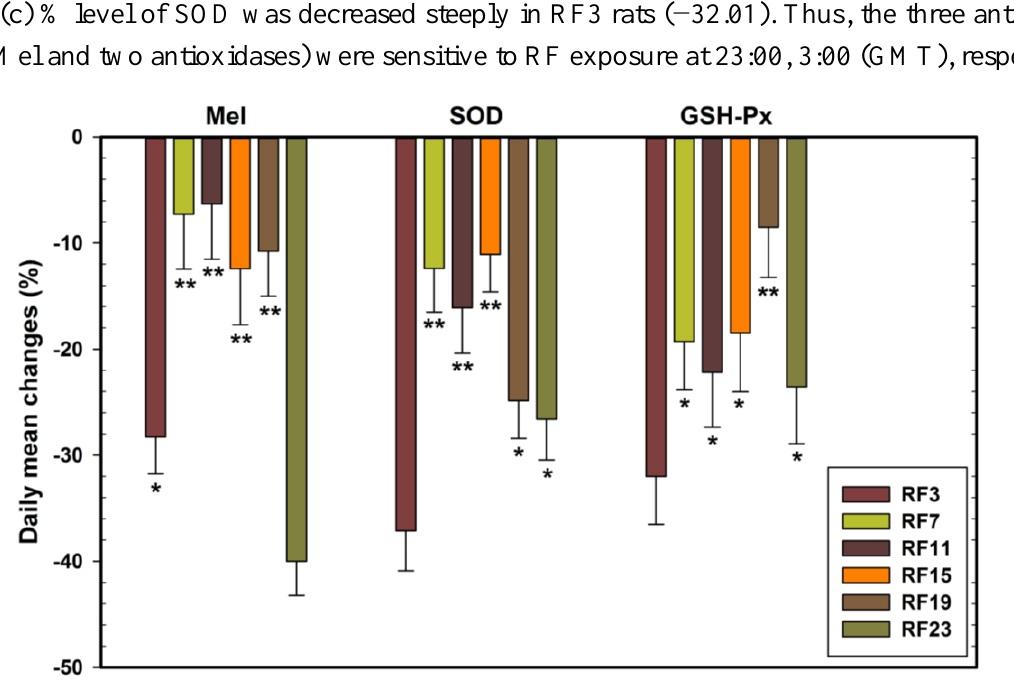
Figure 7. Percentage changes in the daily mean of Mel, GSH-Px and SOD in the plasma of sham-exposed rats and those exposed to 1.8 GHz RF at 3, 7, 11, 15, 19, and 23 h GMT for 2 h/per day for 32 consecutive days. Note: (%) = ((Mean RF − Mean Sham )/Mean Sham ) ×